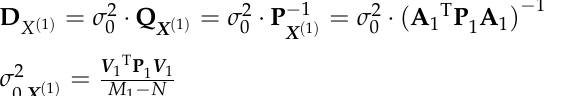
where σ 2 is variance of unit weight. When we obtain a new SAR image in Equation (3), the 0, X ( 1 ) variance-covariance matrix of the deformation time series D